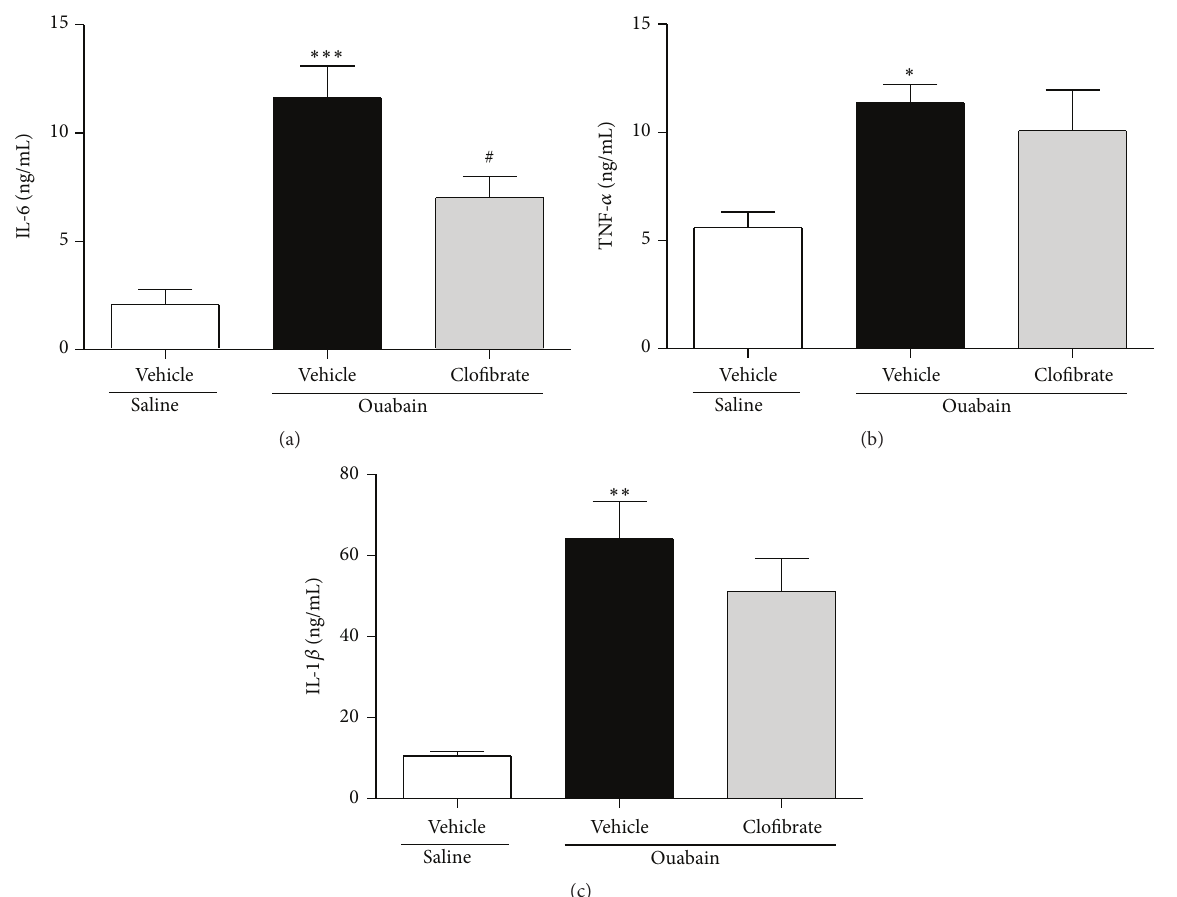
Figure 6: Plasma levels of IL-6 (a), TNF- 𝛼 (b), and IL-1 𝛽 (c) in saline- and ouabain-injected vehicle- and clofibrate-treated groups. Data are shown as mean ± SEM. Four rats were used in each group. ∗ 𝑃 ≤ 0.05 , ∗∗ 𝑃 ≤ 0.01 , and ∗∗∗ 𝑃 ≤ 0.001 compared to saline-injected vehicle-treated group; # 𝑃 ≤ 0.05 compared to ouabain-injected vehicle-treated